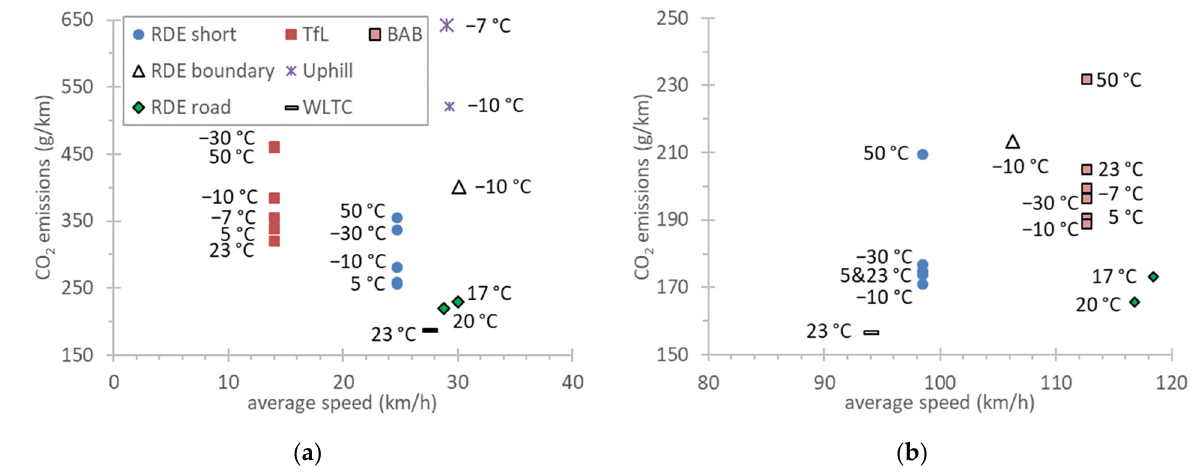
Figure 4. CO 2 emissions in function of mean speed: ( a ) urban cycles (TfL, uphill) or urban parts of the rest cycles (RDE short, RDE boundary, RDE road, and WLTC low and medium phases); ( b ) motorway cycle (BAB) or motorway parts of the rest cycles (RDE short, RDE boundary, RDE road, and WLTC extra high phase). The ambient temperature of each test is indicated next to each test.